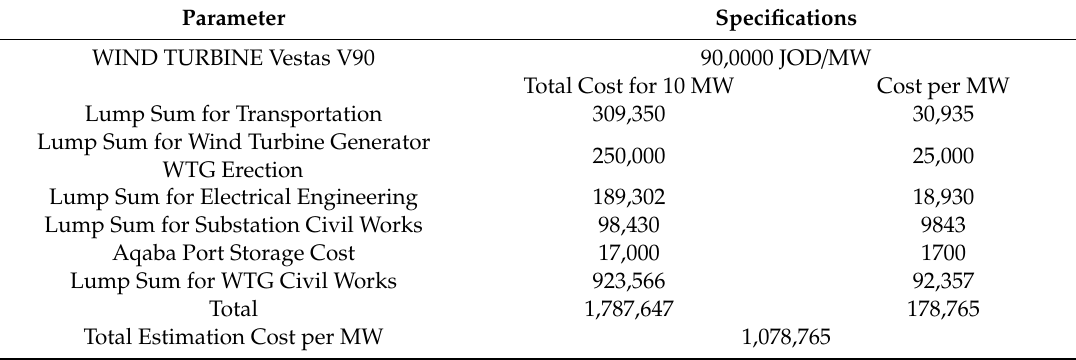
Table 2. Estimated initial cost for wind